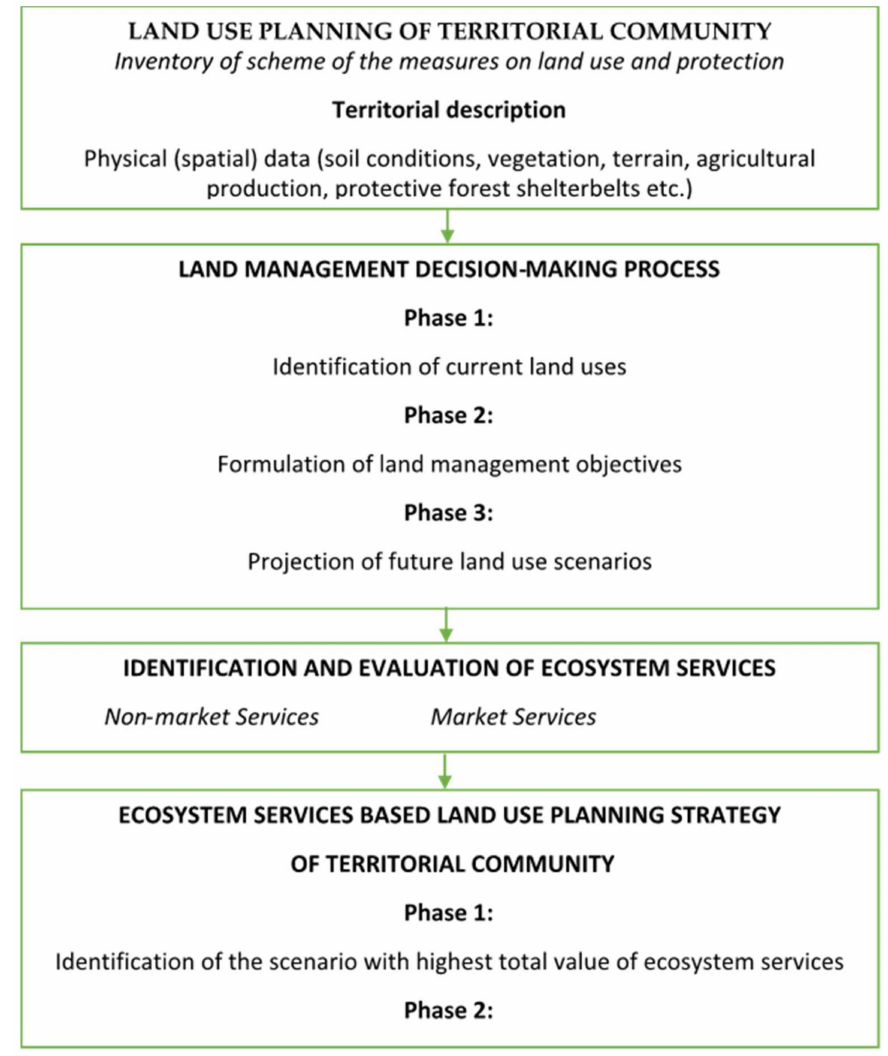
Figure 1. Algorithm of valuation of ES under alternative management scenarios in land use